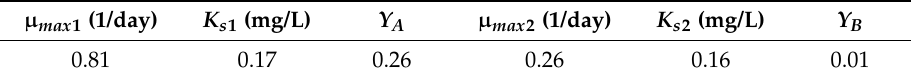
Table 1. Parameters of model #1 (adapted from